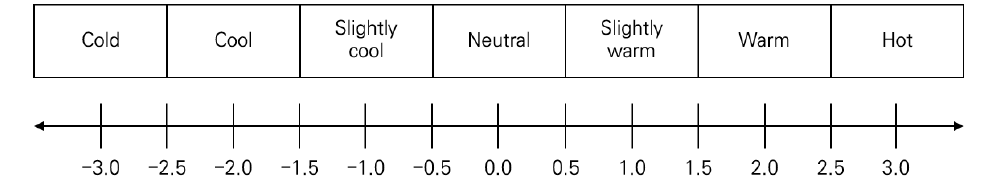
Figure 13. ASHRAE thermal sensation scale.